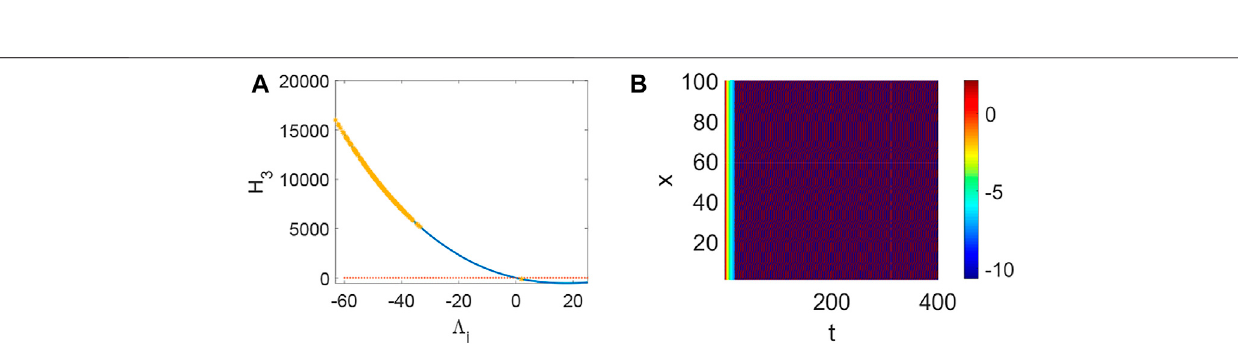
FIGURE 3 | The stability of system (1) when p = 0.05, q = 0.96, τ = 0. (A) The distribution of eigenvalues Λ i (labeled by *). (B) Turing instability occurs in system (1) when some eigenvalue Λ i make H 3 < 0 hold.